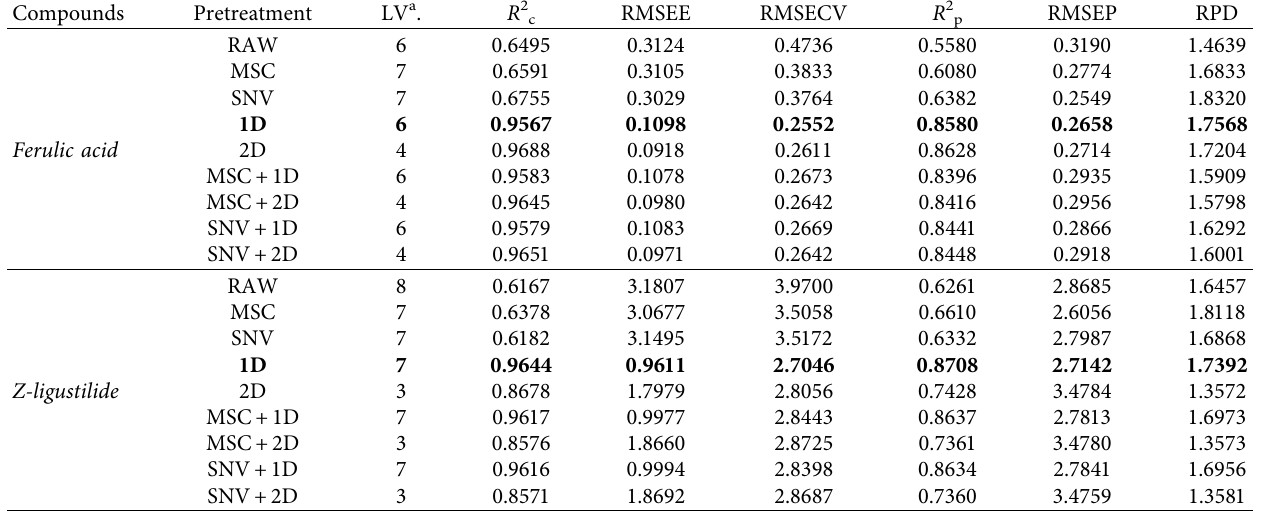
Table 4: Parameters of PLSR models for the determination of ferulic acid and Z-ligustilide in ASR using FT-NIR based on different pretreated methods.